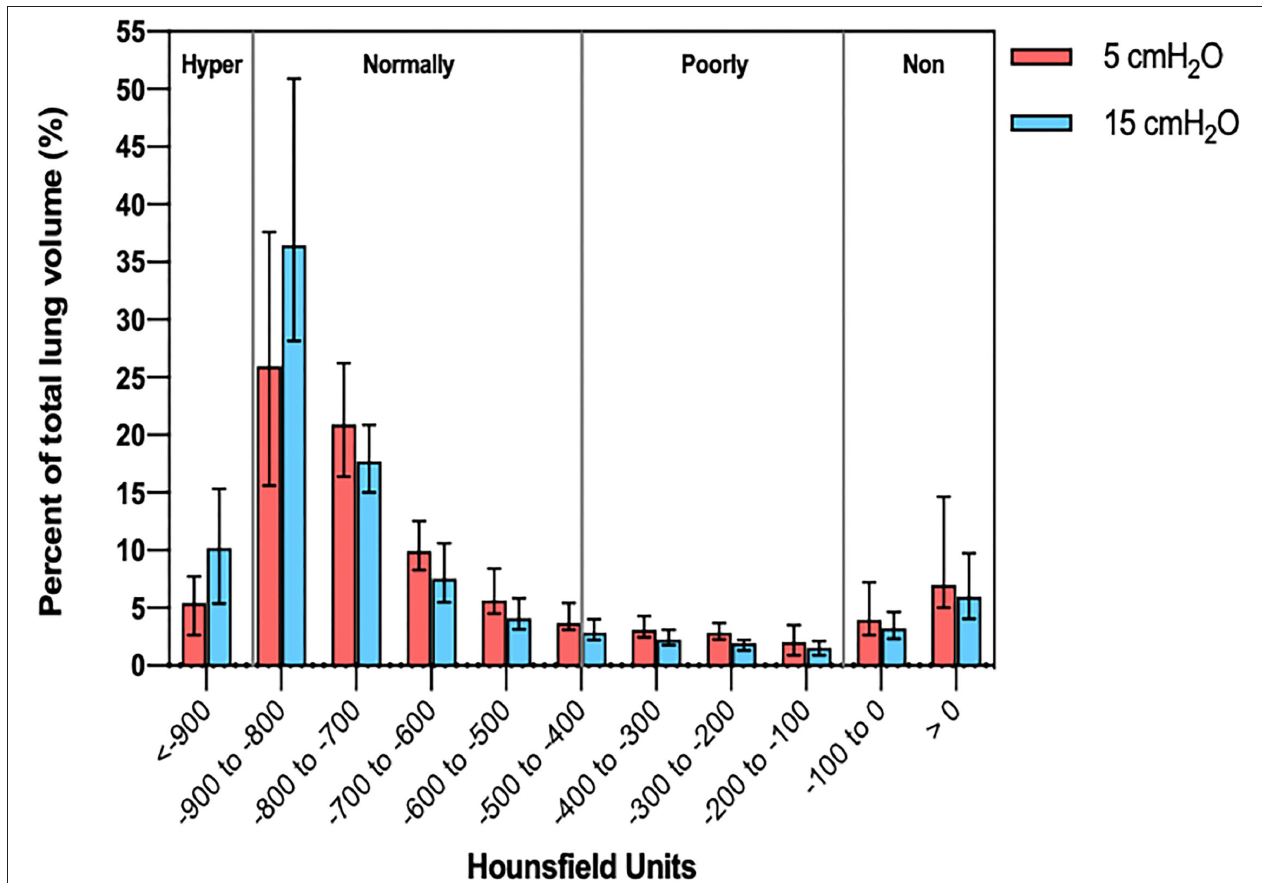
FIGURE 3 | Histogram distribution of lung volume aeration at 5 and 15 cmH 2 O of PEEP. PEEP, positive end-expiratory